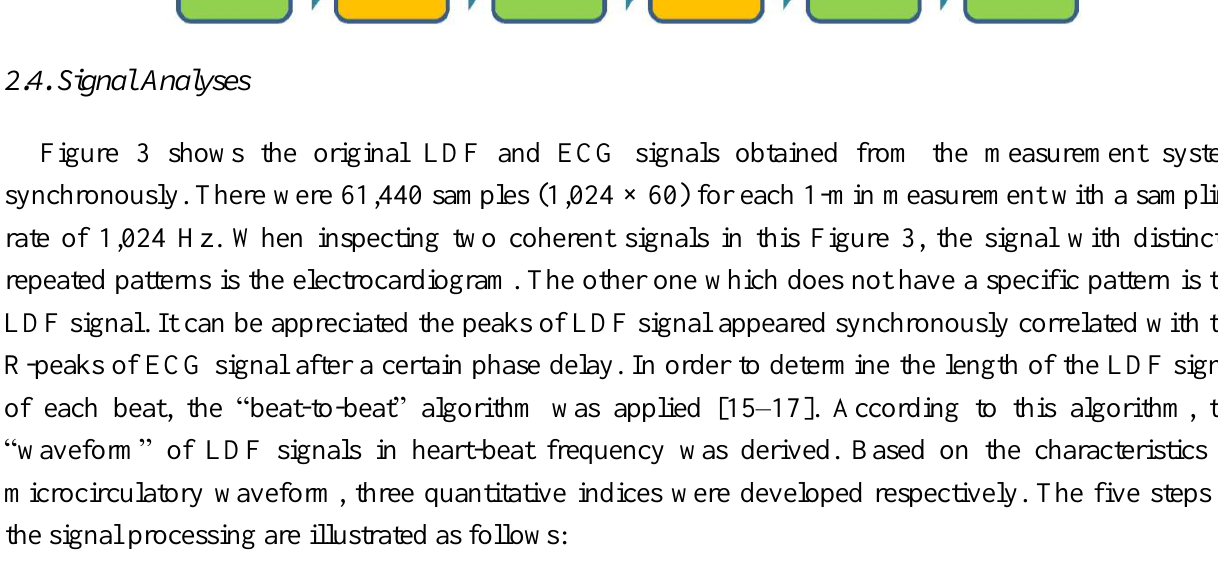
Figure 2. Six measurements in the experimental protocol schedule. Muscle was in relaxed states during BL, R1, R2 and R3, whereas AS1 and AS2 were the stretching